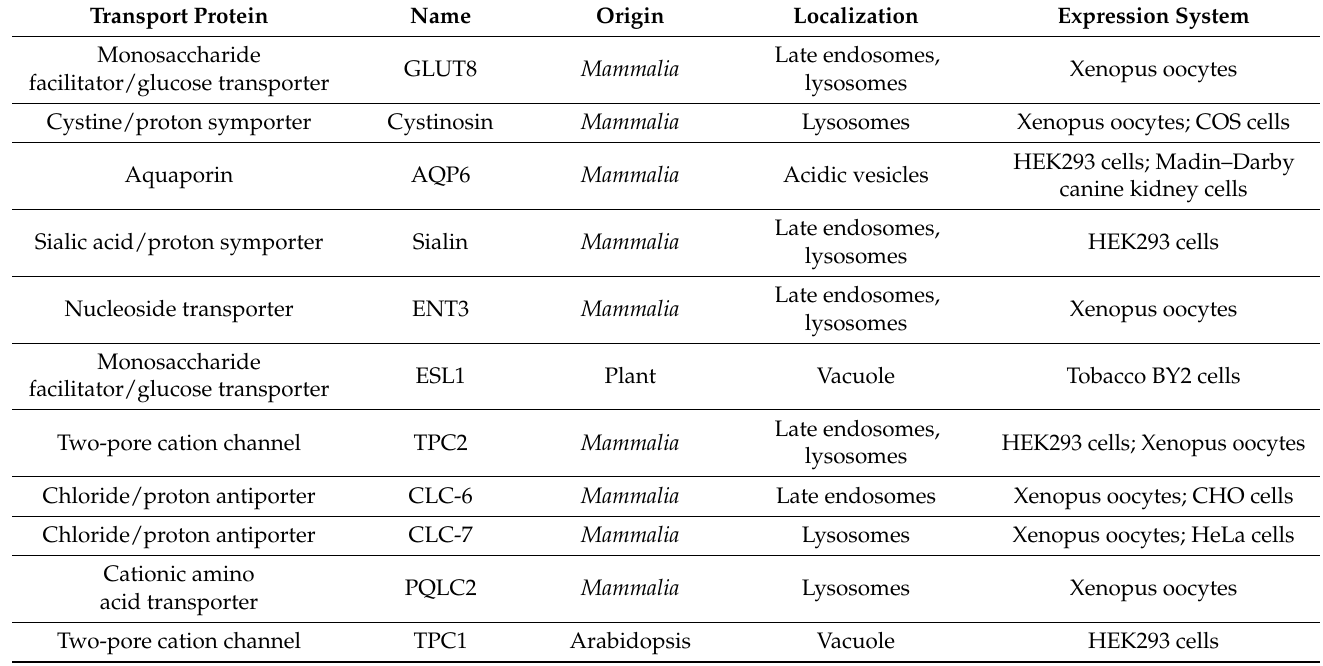
Table 3. Intracellular transport proteins functionally expressed in the plasma membrane after manip- ulation of sorting/internalization motifs (related references inserted in the main